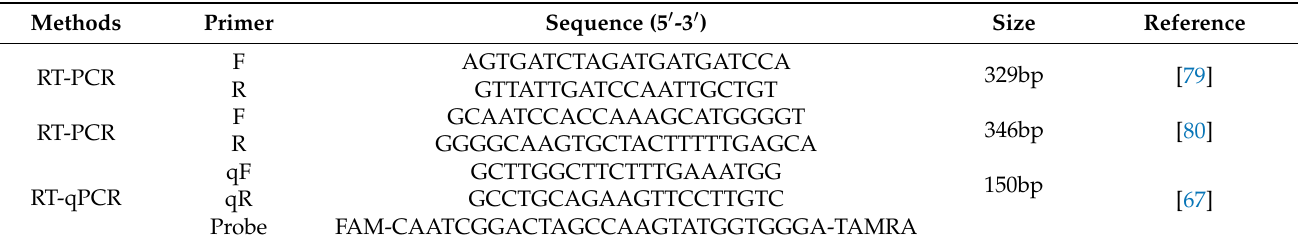
Table 3. Nucleotide acid detection methods used for CPIV3